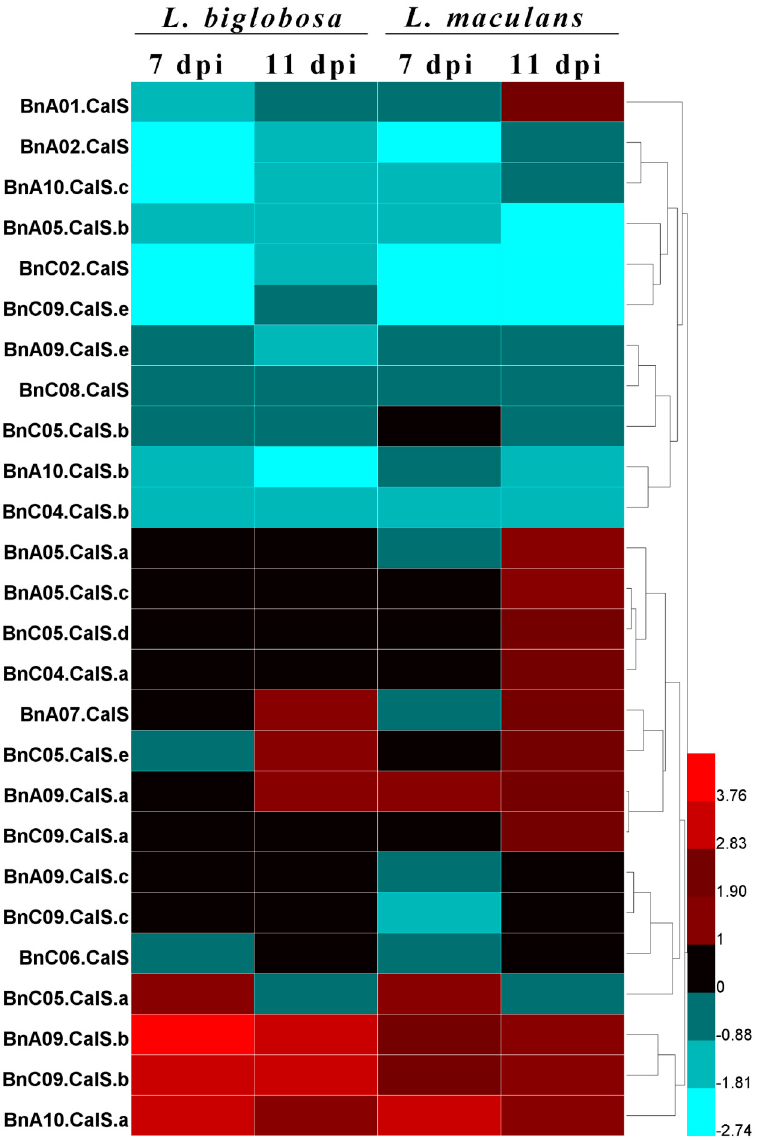
Figure 10. Heapmap of the expression profiles of BnCalS genes in Westar plants subjected to L. biglobosa or L. maculans infection. The TPM value of each gene was used as the expression level, the relative value was obtained by comparing TPM values of Westar inoculated with L. maculans or L. biglobosa with Westar inoculated with water, and the color scale was based on the log2 (relative value). Samples with L. maculans or L. biglobosa are indicated on the top of the heatmap, and genes are indicated at the left side of the heatmap. Twenty-six genes were shown and the other 6 were not included because of low or no expression in these samples.